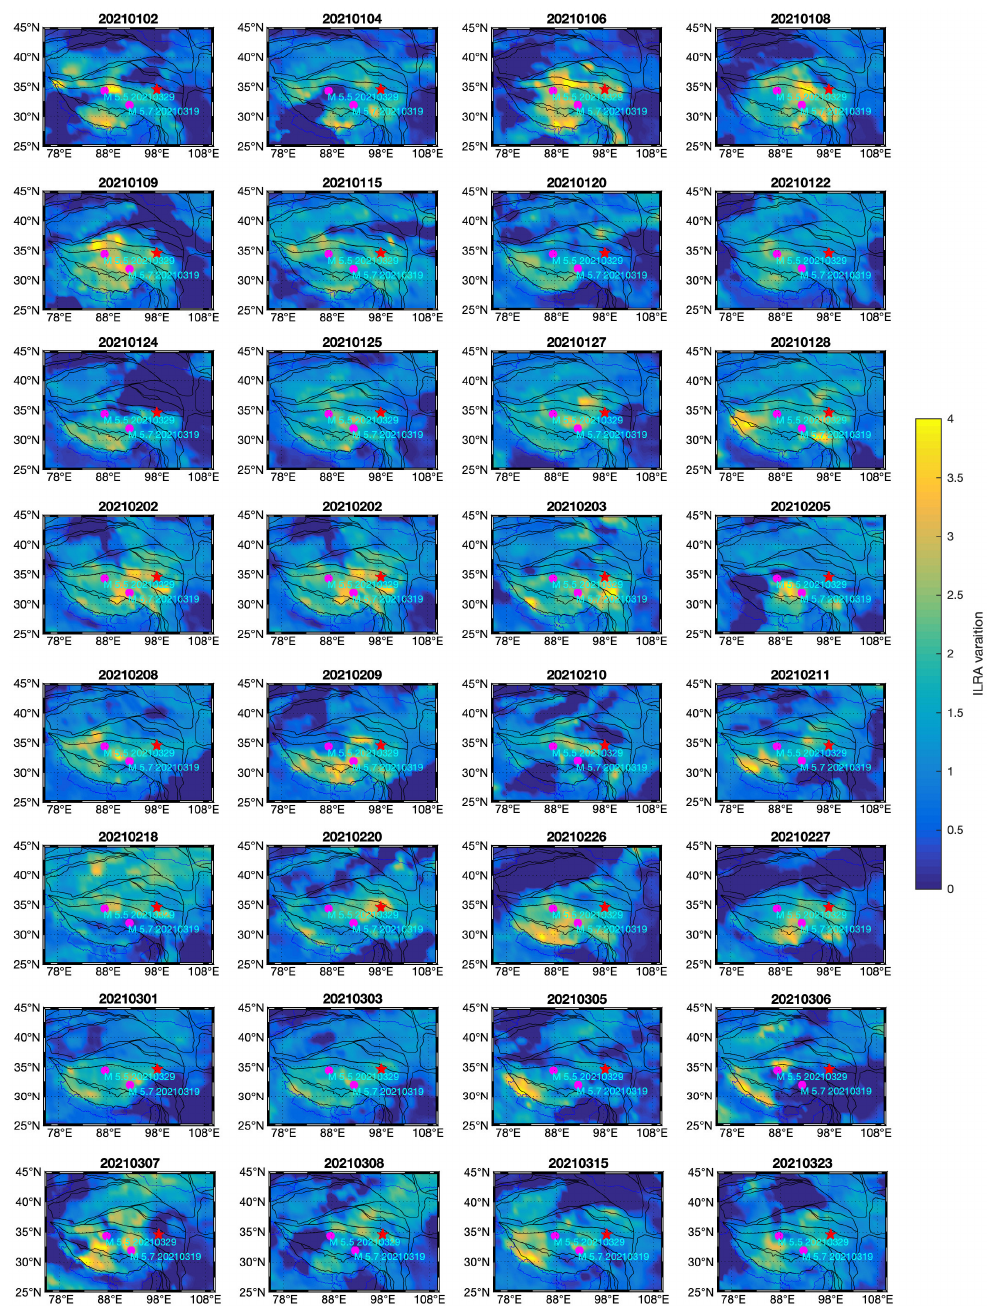
Figure 11. Spatial distribution of ILRA variation from January to March 2021. Black lines indicate the boundaries of tectonic blocks. The red stars indicate the epicenter of the Madoi M 7.3 earthquake, and magenta dots indicate two moderate earthquakes in March 2021.